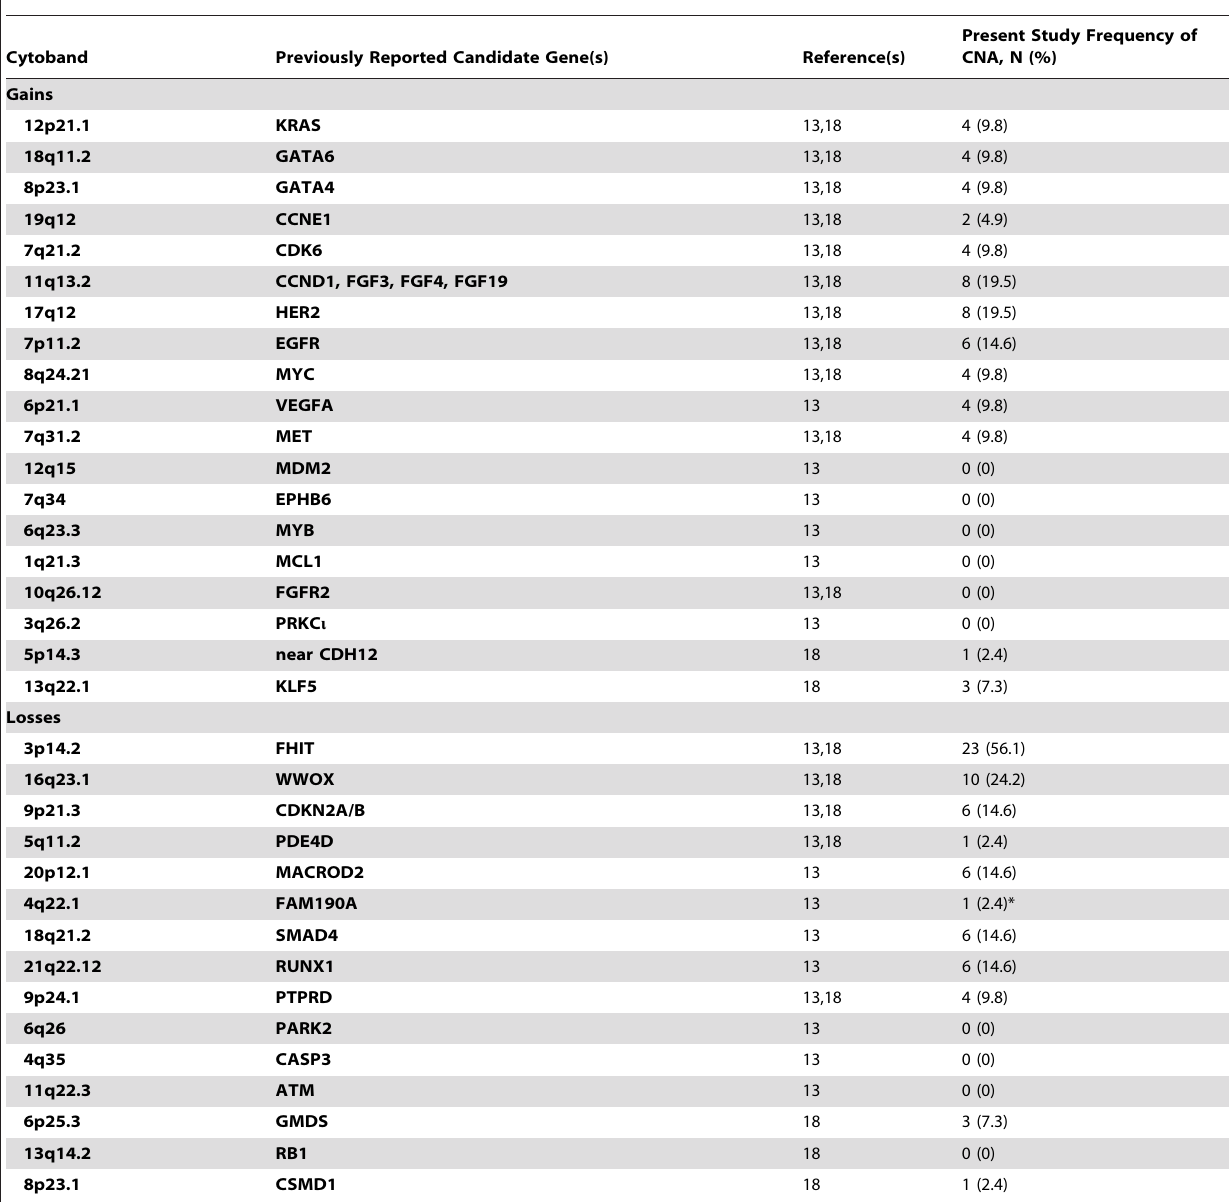
Table 2. Prevalence of Copy Gains and Losses in Superficial EAC in Previously Reported Candidate Genes.